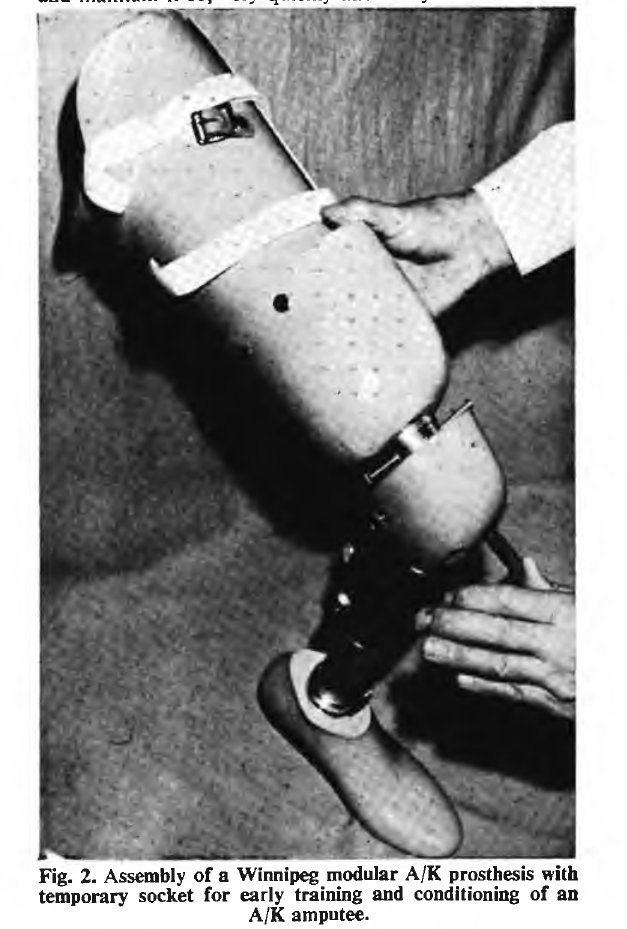
Fig. 2. Assembly of a Winnipeg modular A/K prosthesis with temporary socket for early training and conditioning of an A/K